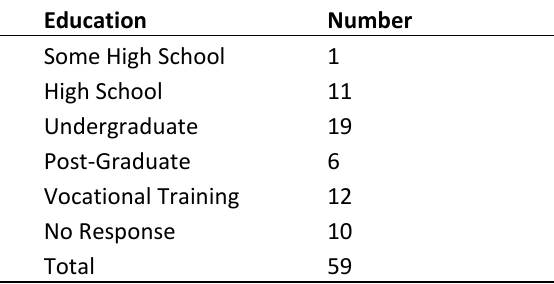
Table 2. Completed education level.